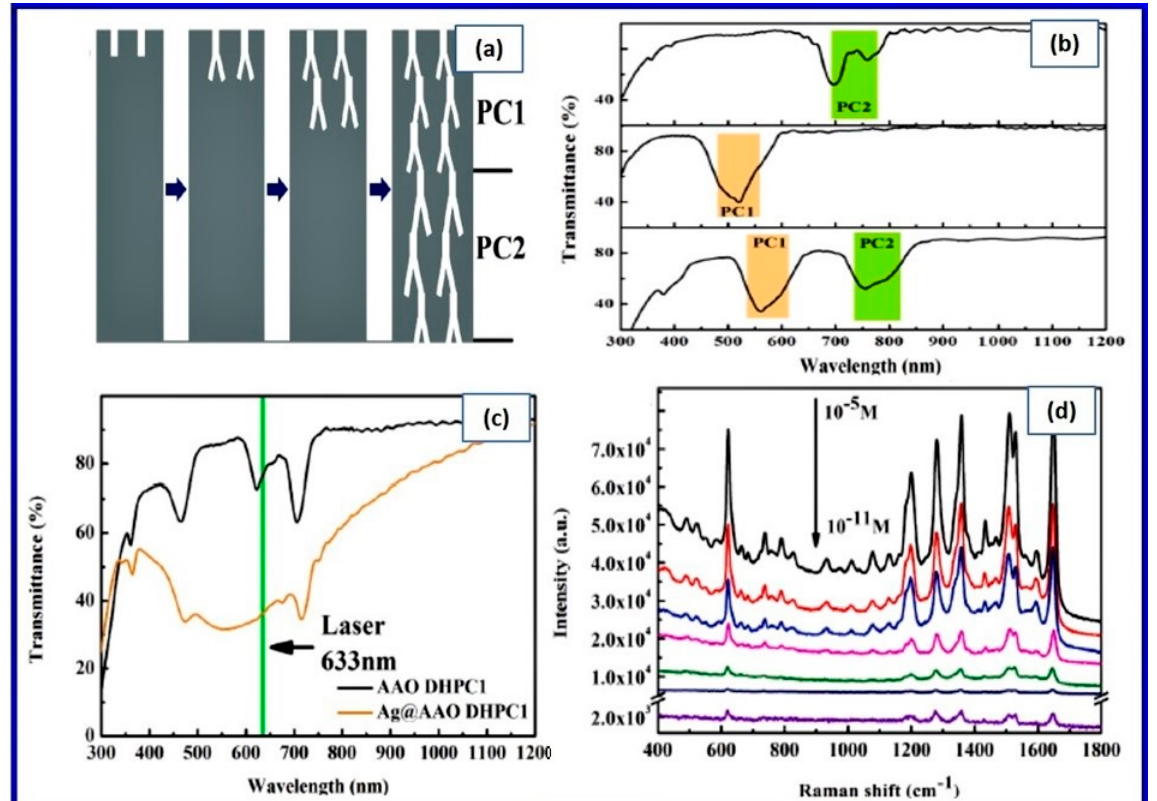
Figure 12. NAA—DHPC SERS substrates: ( a ) Schematic showing the individual and dual bandgap heterostructure photonic crystals; ( b ) UV—Visible transmission spectra of PC1, PC2, and DHPC; ( c ) transmission spectra multiple photonic bandgaps in the visible region; and ( d ) SERS spectra showing variation in Raman intensity with varying RhB concentration. Reproduced with permission from Xiao-Gang Wang, Jian Wang, Zi-Jin Jiang, Dai-Wen Tao, Xu-Qiang Zhang, and Cheng-Wei Wang, Applied Surface Science 544, 148,881 (2021). Copyright 2021 Elsevier [288].